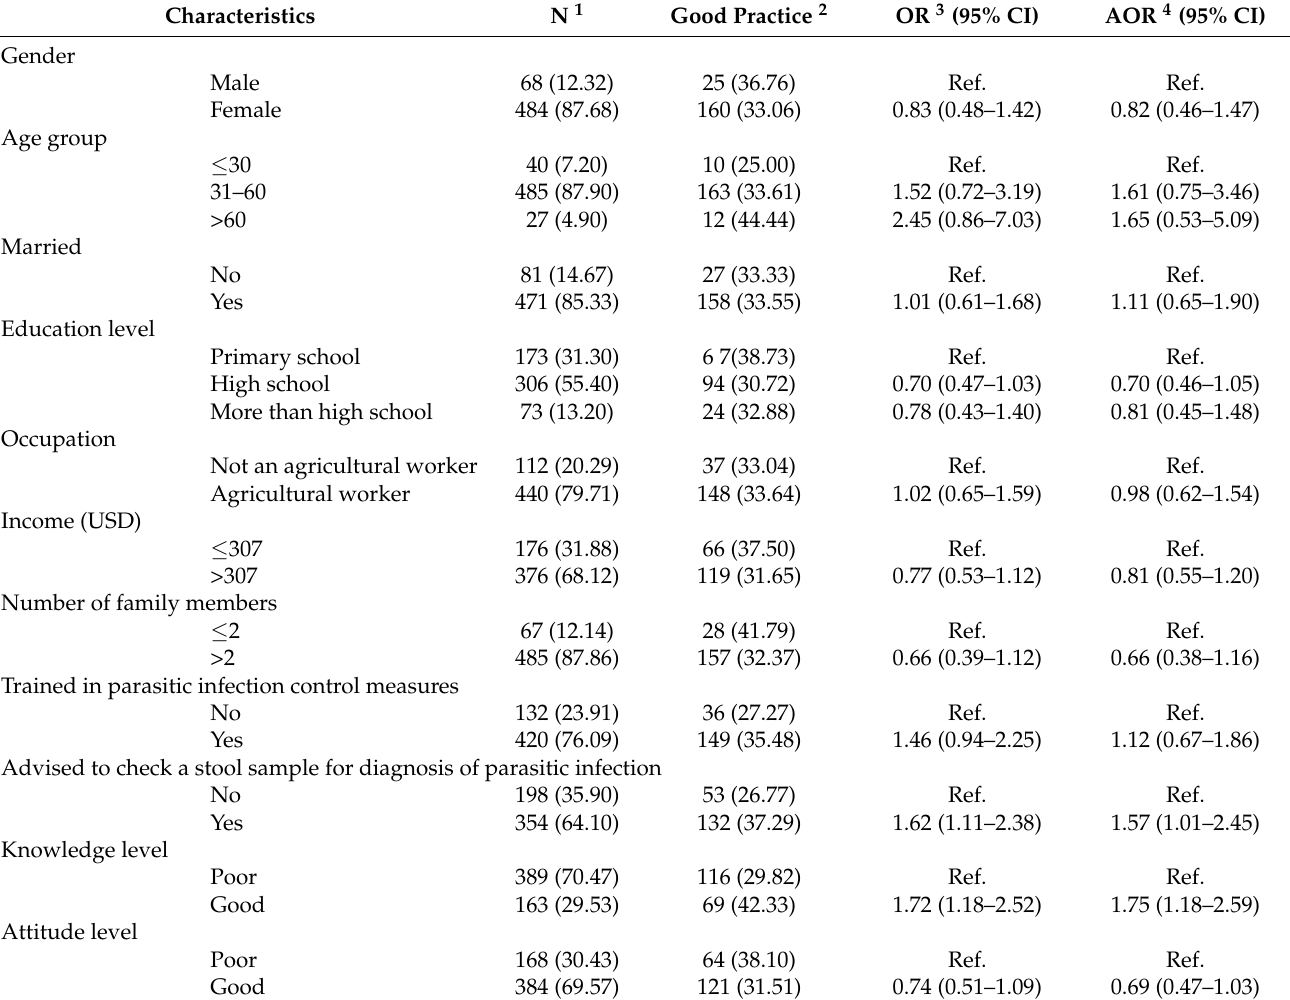
Table 6. Univariate and multivariate mixed-effect logistic regression analysis of factors influenc- ing